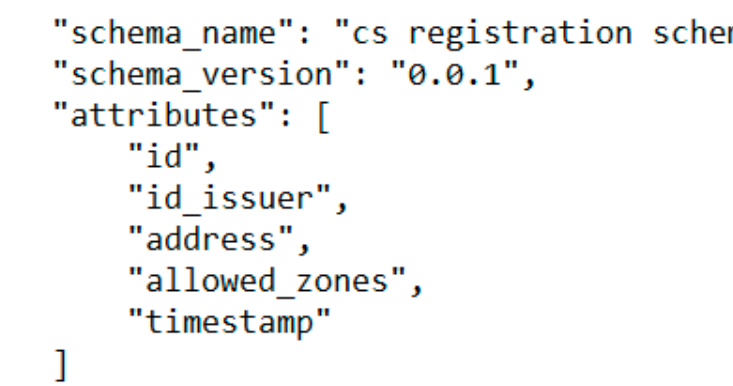
Figure 21. CS verifiable JSON credential schema definition.